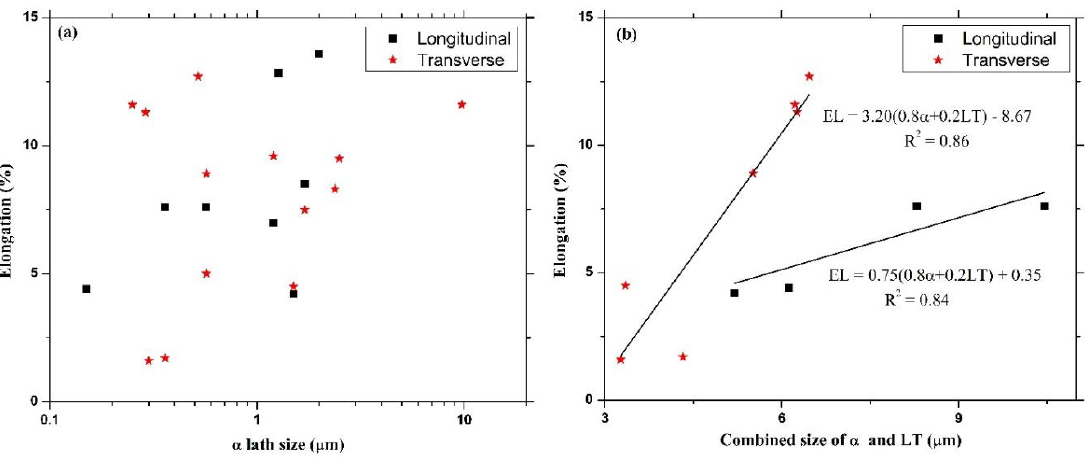
Figure 5. Plot between percentage elongation and ( a ) α lath size for as-built and heat-treated